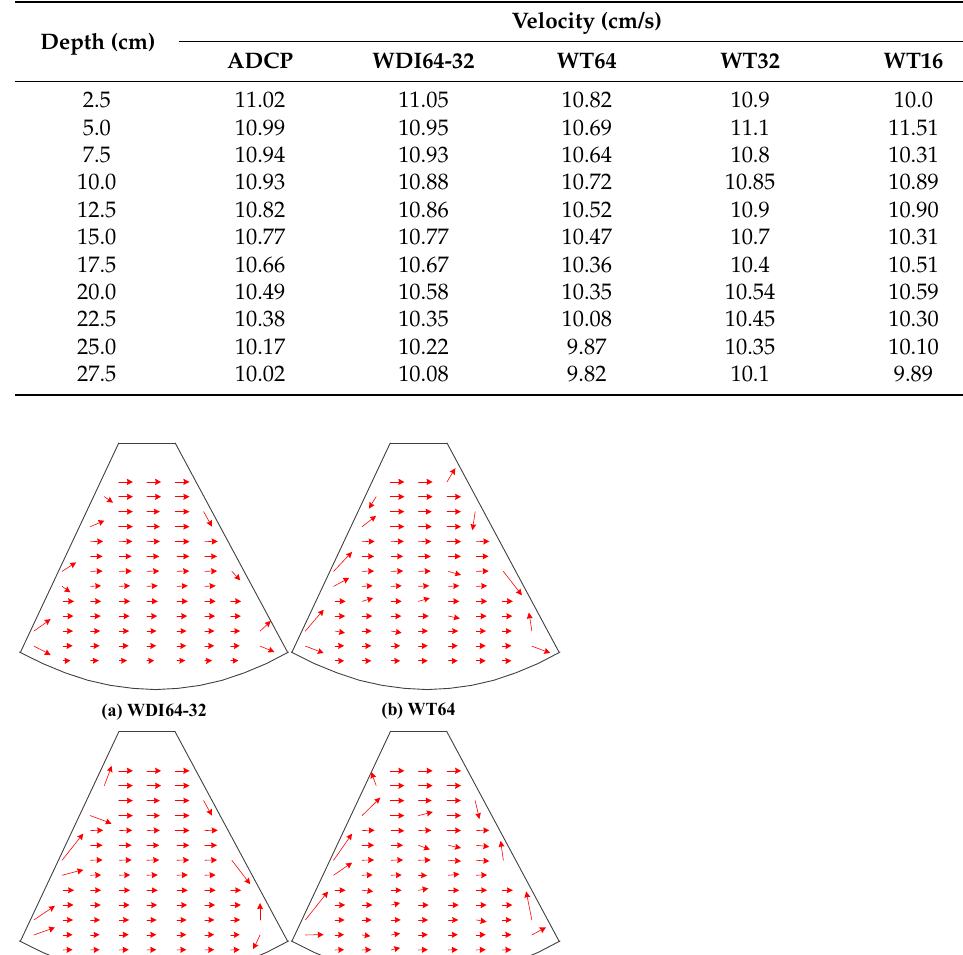
Table 2. The profile velocities data in silt carrying flow measured by using the ADCP, the WDI64-32, the WT64, the WT32, and the WT16, respectively.